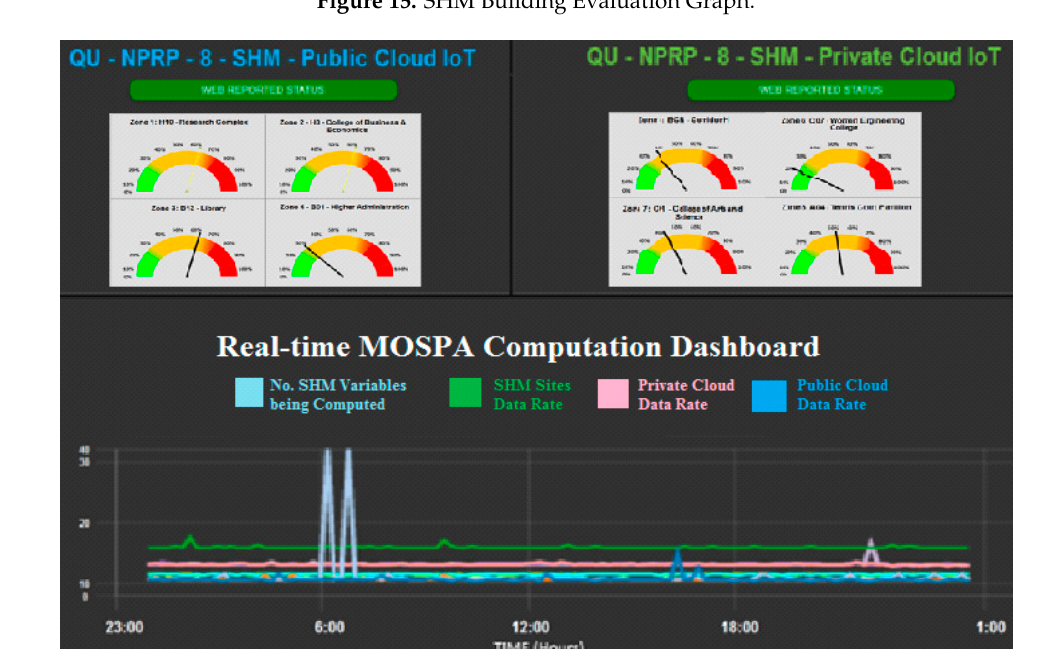
Figure 15. SHM Building Evaluation Graph.